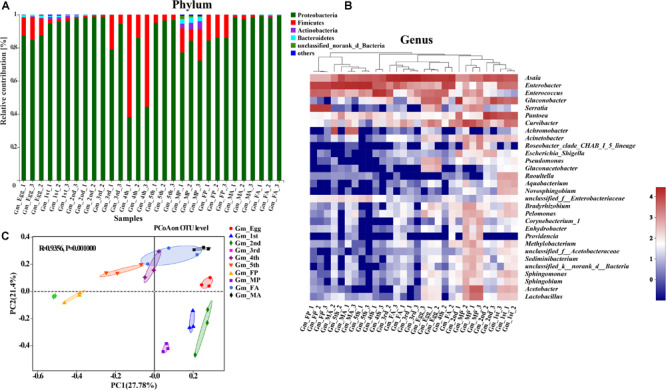
Gut bacterial dynamics across the development of G. molesta.
(A) Relative abundance of bacterial communities at the phylum level in different treatments. (B) Heat map of major taxa at different life stages at the genus level generated by cluster analysis using the average method. Each column represents a single replicate for each of the 10 treatments. Columns were clustered according to the similarity of bacterial abundance profiles. Each row represents an OTU assigned to the genus level. Color gradients represent the abundance variation of different species in the sample. Plotting scale, from red to blue, indicates the decrease in relative abundance of bacteria. (C) Principal coordinate analysis (PCoA) of microbial communities according to host developmental stage (ANOSIM test, P = 0.001). Abbreviations: Gm = Grapholita molesta, 1st = first instar, 2nd = second instar, 3rd = third instar, 4th = fourth instar, 5th = fifth instar, FP = female pupa, MP = male pupa, FA = female adult, and MA = male adult.